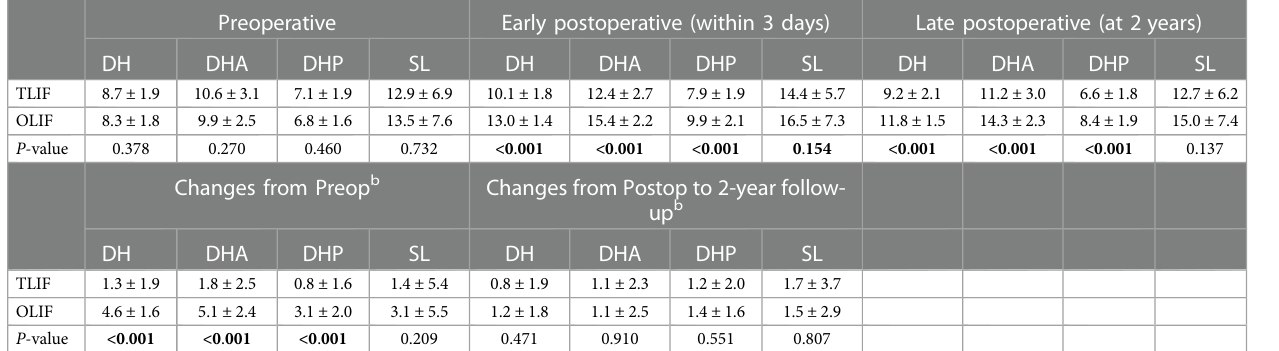
TABLE 4 Comparisons of radiographic parameters between OLIF and TLIF groups a